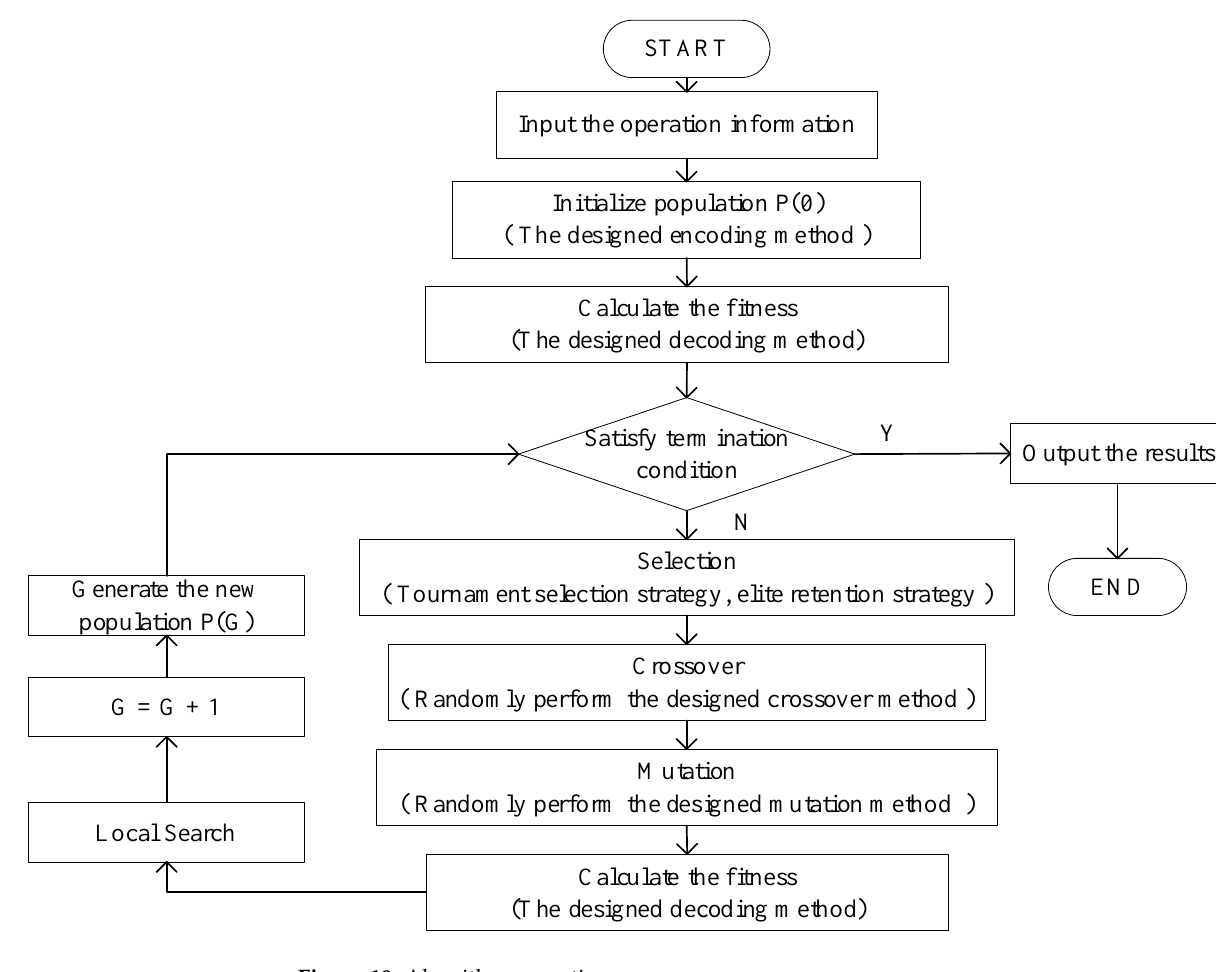
Figure 10. Algorithm execution process.